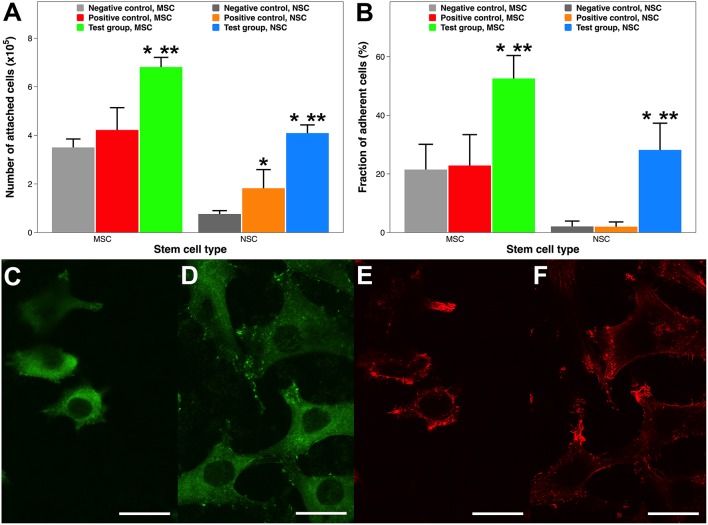
Stem cell attachment and adhesion on surgical implants with and without ECM protein coatings. (A) Quantitative evaluation of MSC and NSC attachment 12 h after inoculation. (B) Adherence fraction of stem cells after enzymatic detachment. (C–F) CLSM images of MSCs morphology. (C) Vinculin focal adhesion on Ti substrate. (D) Vinculin focal adhesion on collagen coating by atmospheric plasma. (E) Actin cytoskeleton on Ti substrate. (F) Actin cytoskeleton on coating by atmospheric plasma. Scale bar = 15 μm. A single asterisk denotes statistical significance when comparing a test group or positive control with a negative control, and a double asterisk when comparing a test group with a positive control.